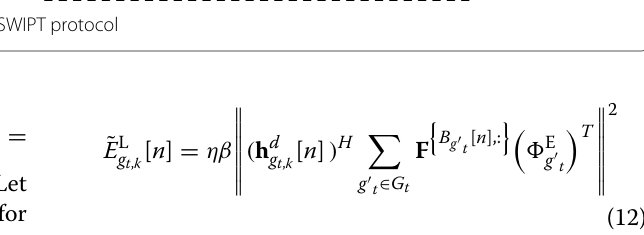
Fig. 4 Illustration of the signal flow for the proposed beam-domain SWIPT protocol